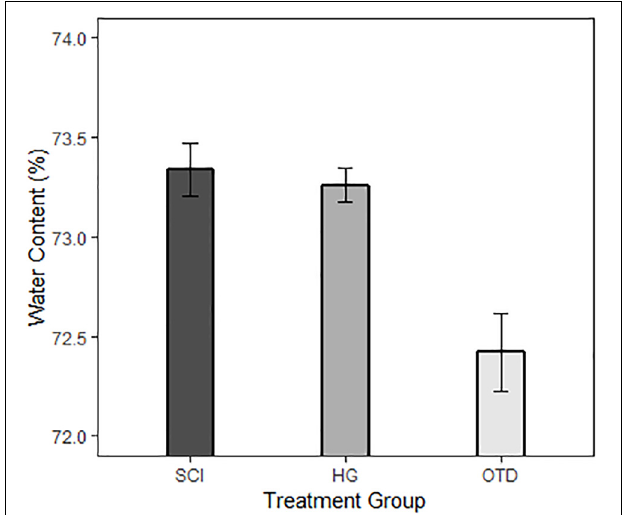
FIGURE 4 | Effects of OTD treatment on % water content after severe SCI at T8. Percent (%) water content calculated SCI only, SCI + hydrogel (HG), and SCI + OTD rats following 3 h of treatment. The figure shows a statistical reduction in % water content in tissue following OTD treatment. Values are shown for 5 mm segments isolated from the lesion epicenter ( n = 5 for all